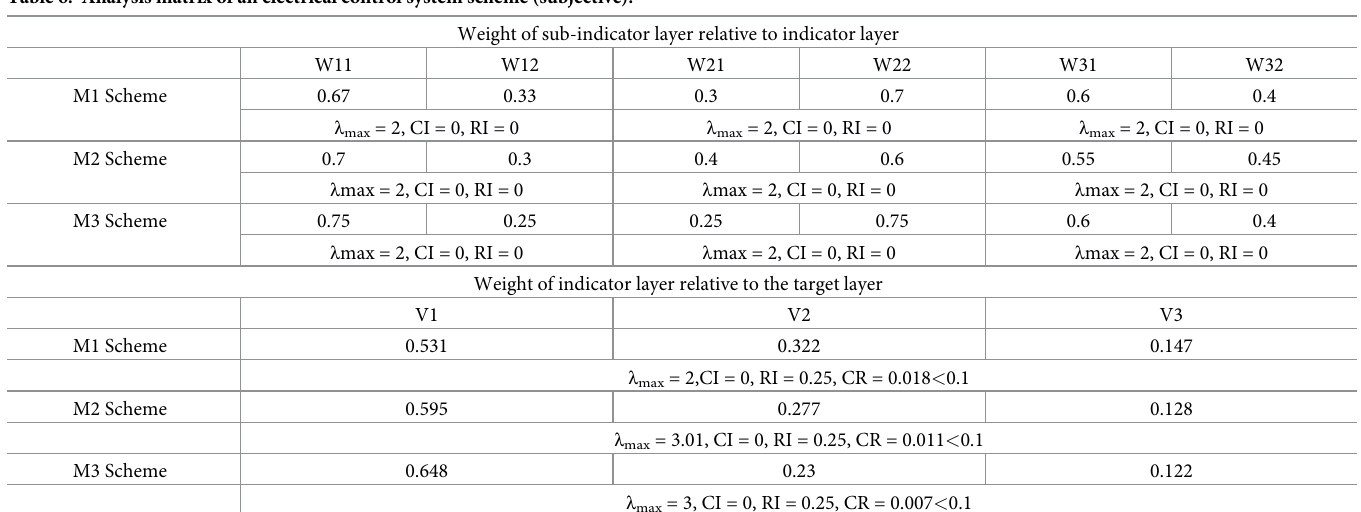
Table 6. Analysis matrix of an electrical control system scheme